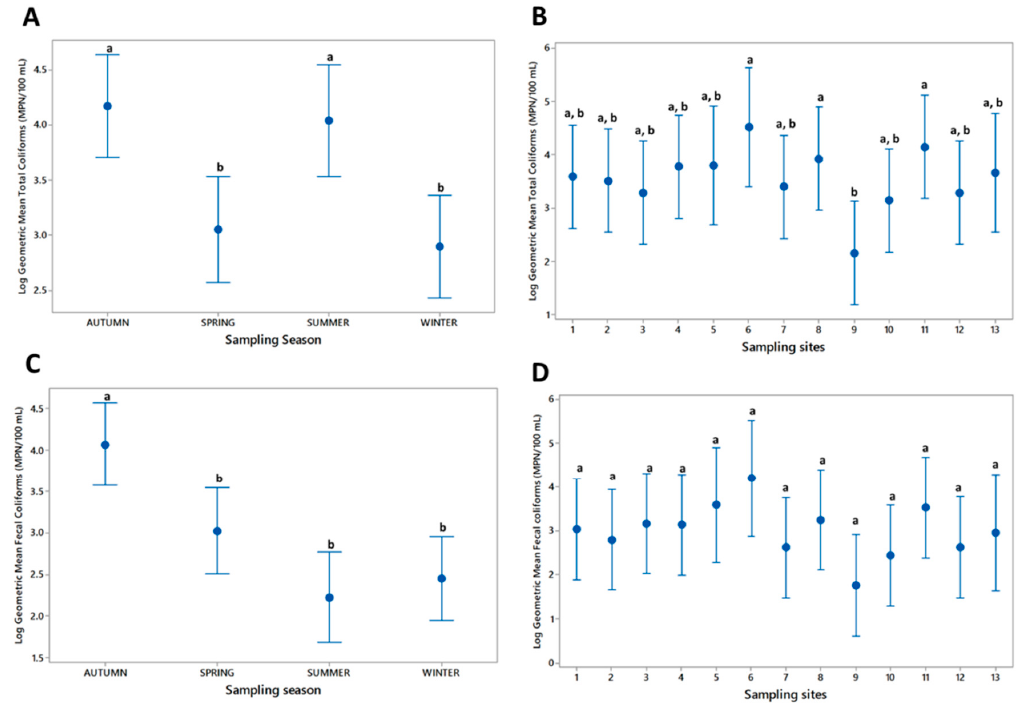
Figure 3. The geometric means considering all sites and all seasons in logarithmic scale and with confidence intervals of 95%. ( A ) Total coliforms per sampling season; ( B ) Total coliforms per sampling site; ( C ) Fecal coliforms per sampling season; ( D ) Fecal coliforms per sampling site. Bars showing different letter are significantly different (Tukey, p < 0.05).